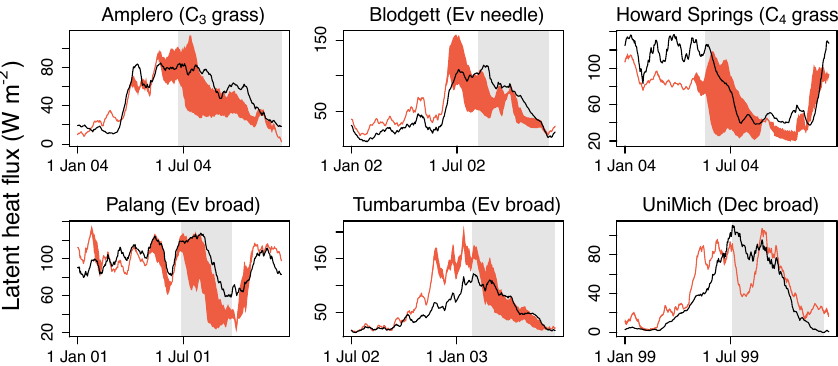
Figure 9. The range in simulated latent heat (red) arising from the individual effects of the slope parameter using the new hydrological scheme during the 1-year period. Observed latent heat is shown in black. The grey shading denotes the selected dry-down period. The individual effects were determined by fixing the other parameterisations at their default values (medium soil, Medlyn g s and centre